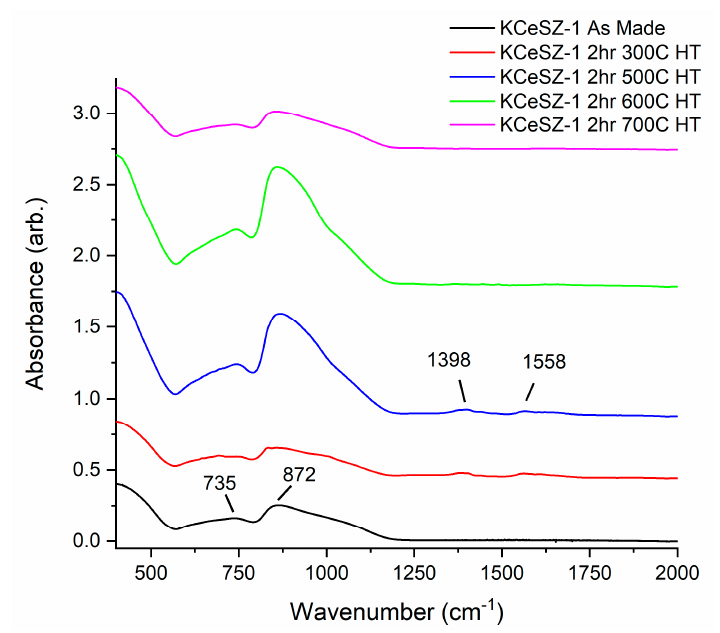
Figure 4. ATR-FTIR spectra of KCeSZ-1 glasses exposed to 2 h hydrothermal treatments in air at temperatures between 300 and 700 °C.